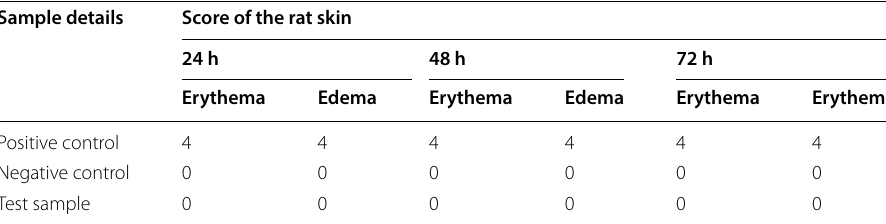
Primary Irritation Index (P.I.I.) for developed sample